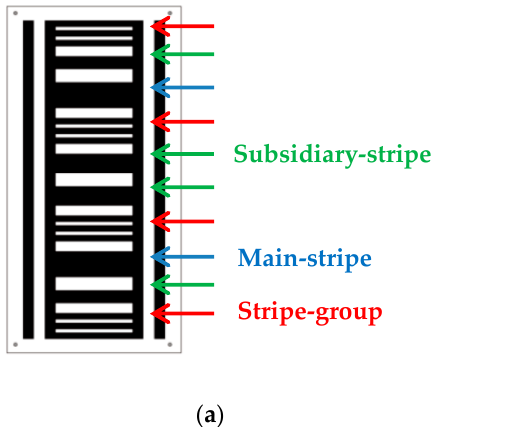
Figure 2. Subsidence mark, ( a ) subsidence mark which is designed as a barcode; ( b ) the image shoot during the monitoring.